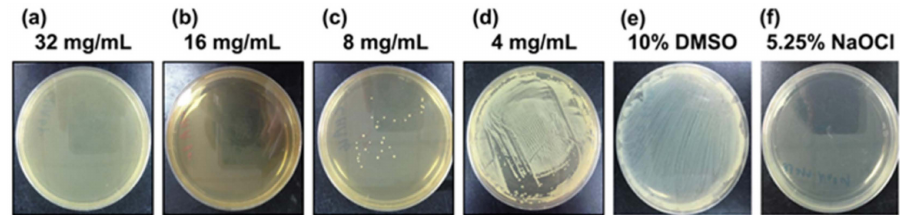
Figure 2. The minimum bactericidal concentration of chlorogenic acid against Porphyromonas gingivalis . The counting colony method was used to determine the MBC. Agar plates were treated with bacterial and ( a ) 32 mg / mL, ( b ) 16 mg / mL, ( c ) 8 mg / mL, and ( d ) 4 mg / mL chlorogenic acid dissolved in 10% dimethyl sulfoxide (DMSO), respectively. ( e ) 10% DMSO and ( f ) 5.25% sodium hypochlorite represented the positive and negative control groups, respectively.